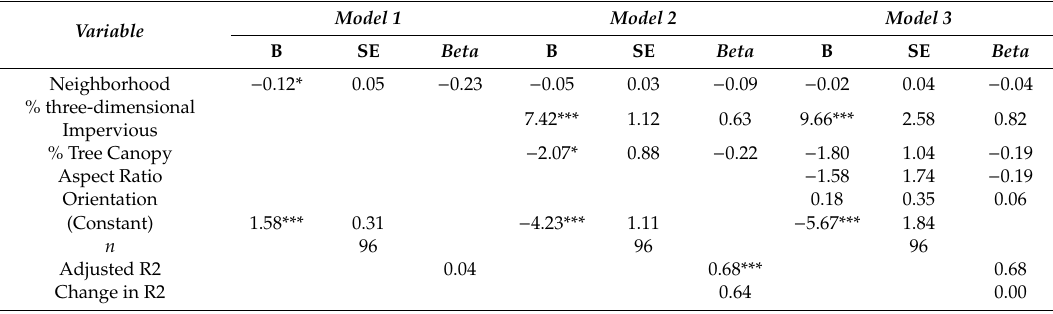
Table 8. Regression analysis for UHI temperatures at 2 a.m. using three-dimensional approach in eight Chicago neighborhoods in summer